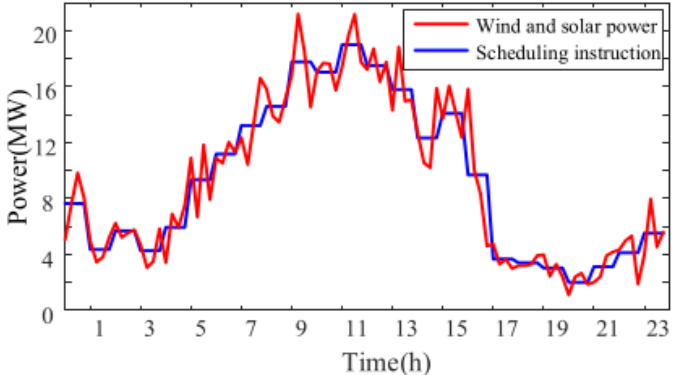
Figure 3. Wind–solar power and scheduling instruction curve.